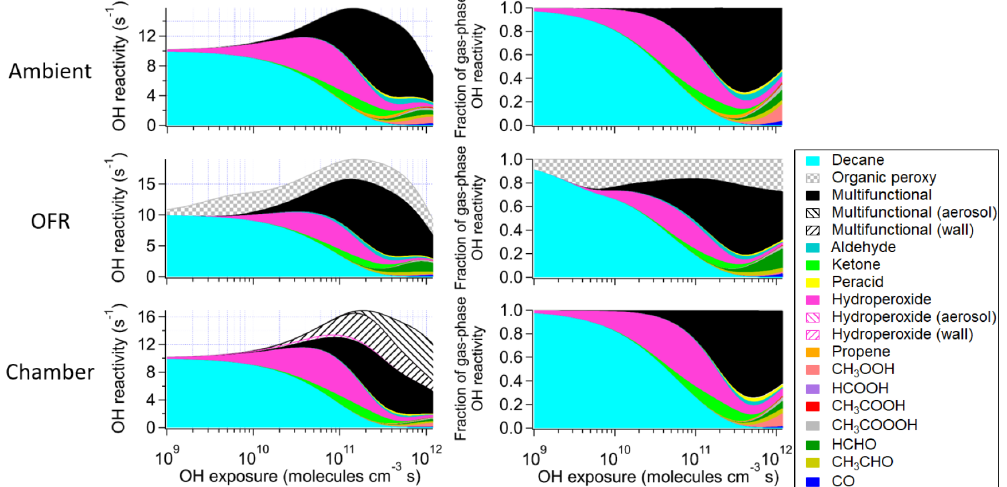
Figure 3. Absolute and fractional contributions to the organic OHR during decane photooxidation of the main species and types of species as a function of OH exposure in the ambient case with constant sunlight; the OFR case with relative humidity of 30%, medium UV lamp setting, and initial OHR of 10s − 1 ; and the chamber case with initial OHR of 10s − 1 and gas–wall partitioning. The types of species shown in this figure exclude the C1 and C2 species listed separately. The OHR of the particle- and wall-phase species are the values as if those species were gas-phase OHR contributors, although they actually do not react with OH in the simulations.